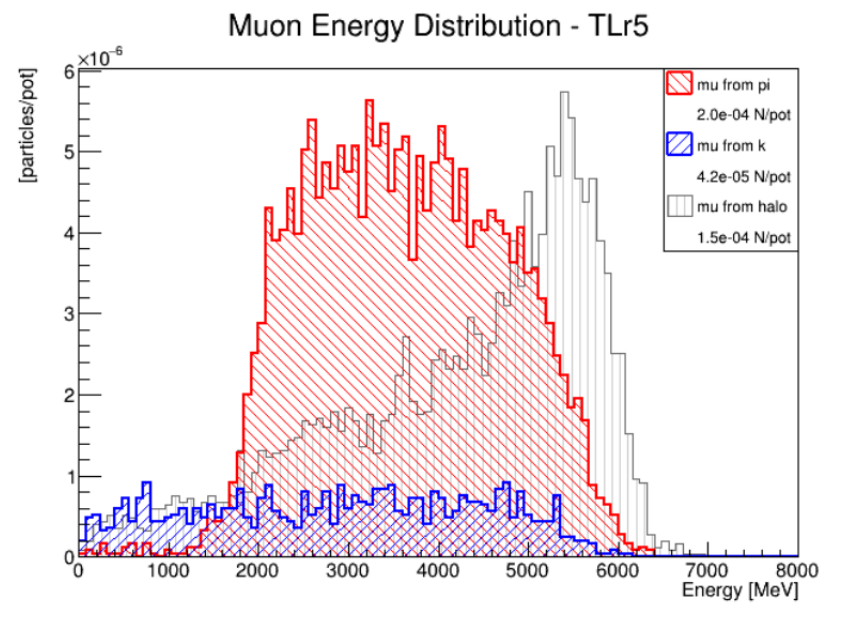
Figure 14. Spectra of muons at the ENUBET muon